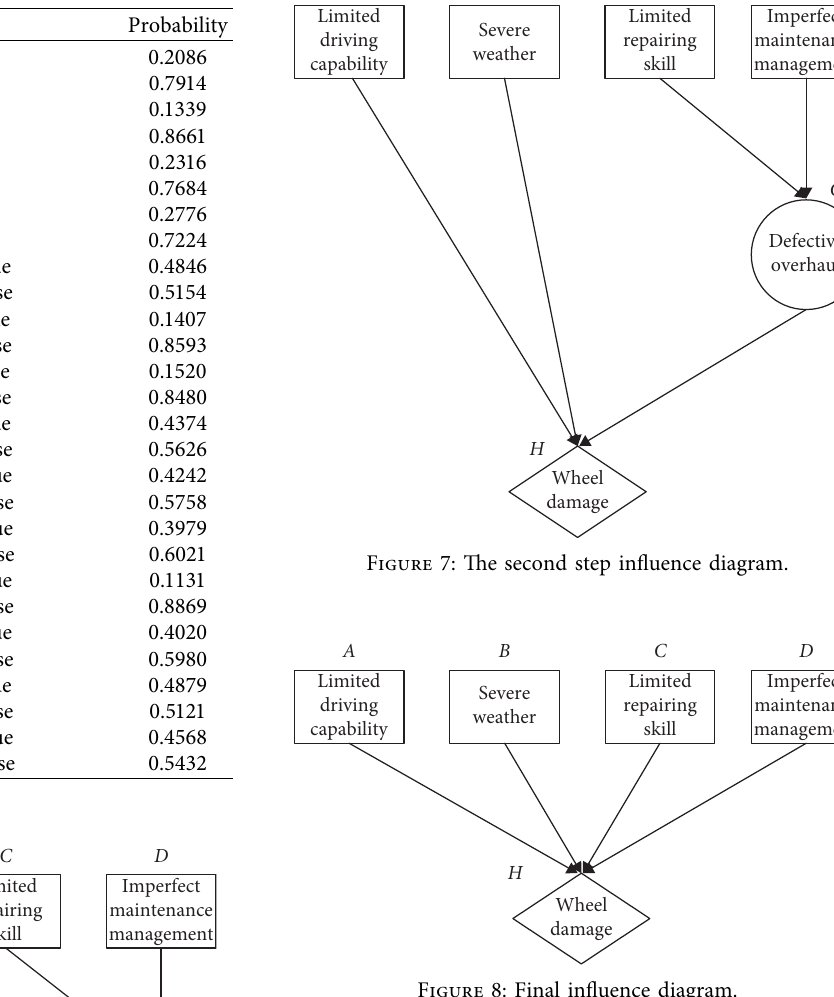
Table 7: Priori and conditional possibility distributions.